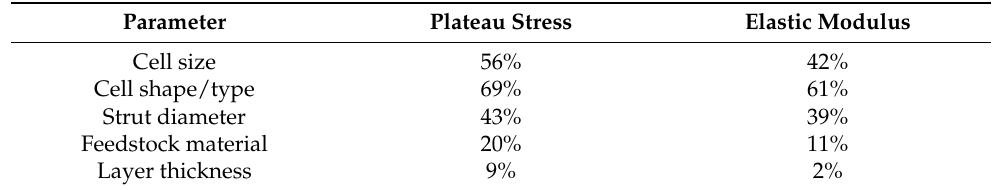
Table 8. Variation in mechanical properties when single factors are changed from the high to the low